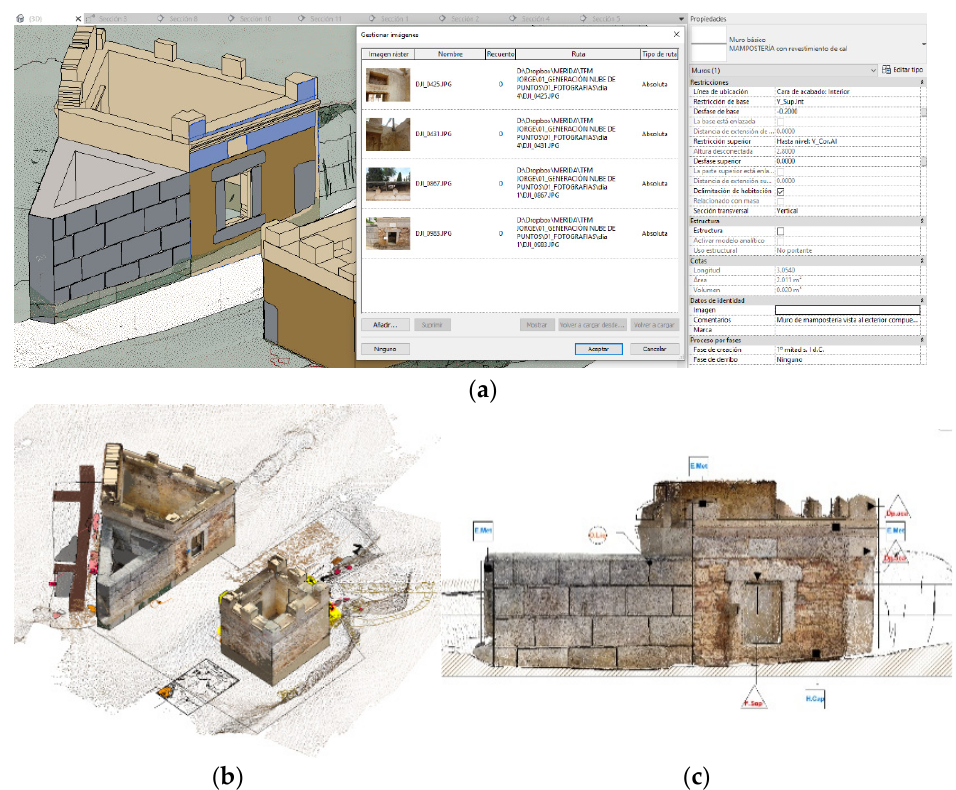
Figure 25. Different visualization styles of the HBIM model whereby one can obtain geometric data of heritage buildings.